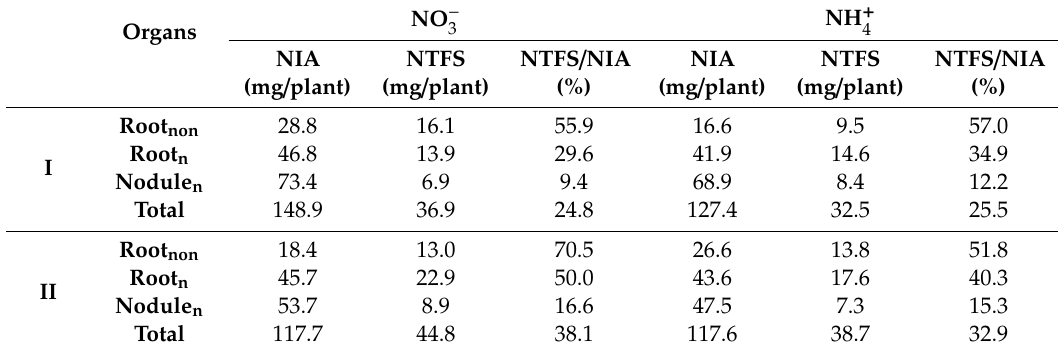
NH + NO − 3 4 NIA NTFS NTFS / NIA NIA NTFS NTFS / NIA (mg / plant) (mg / plant) (%) (mg / plant) (mg / plant)